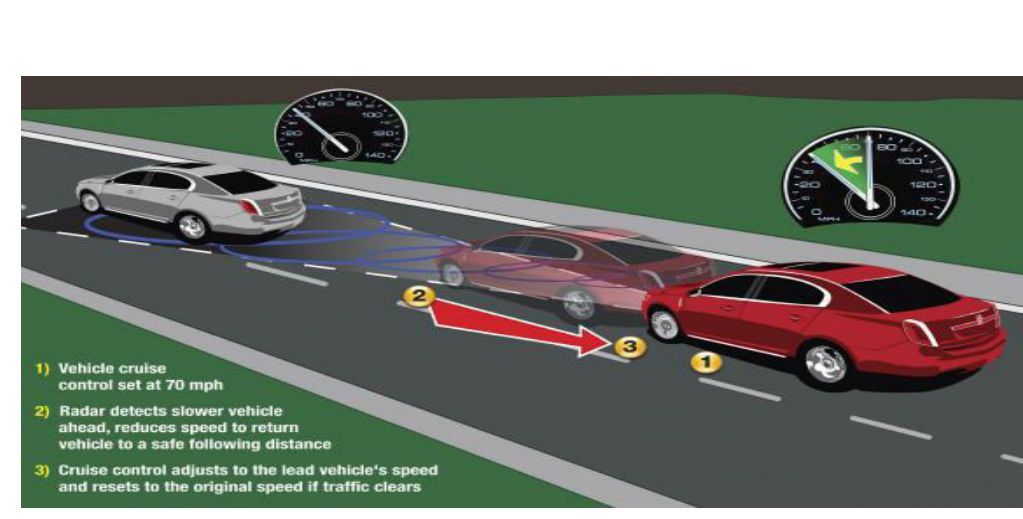
Figure 1. Adaptive Cruise Control system (Prabs,